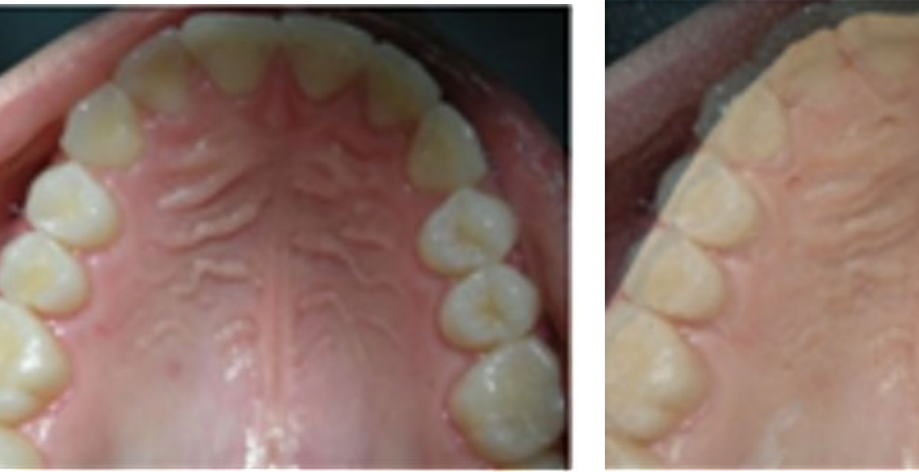
Fig. 4 - Superimposition – photograph and